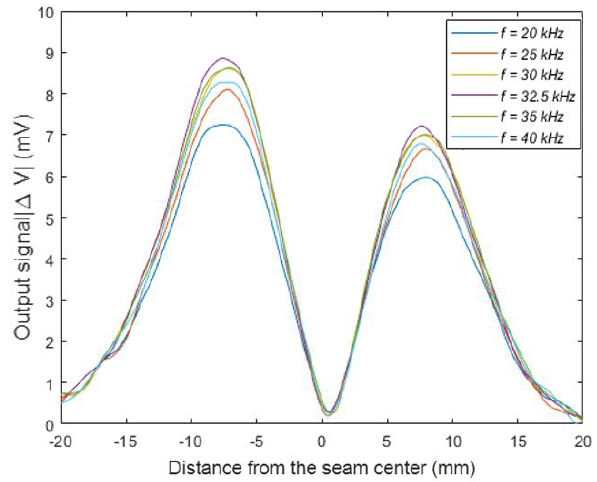
Figure 5. The sensor output signal with a different excitation frequency.